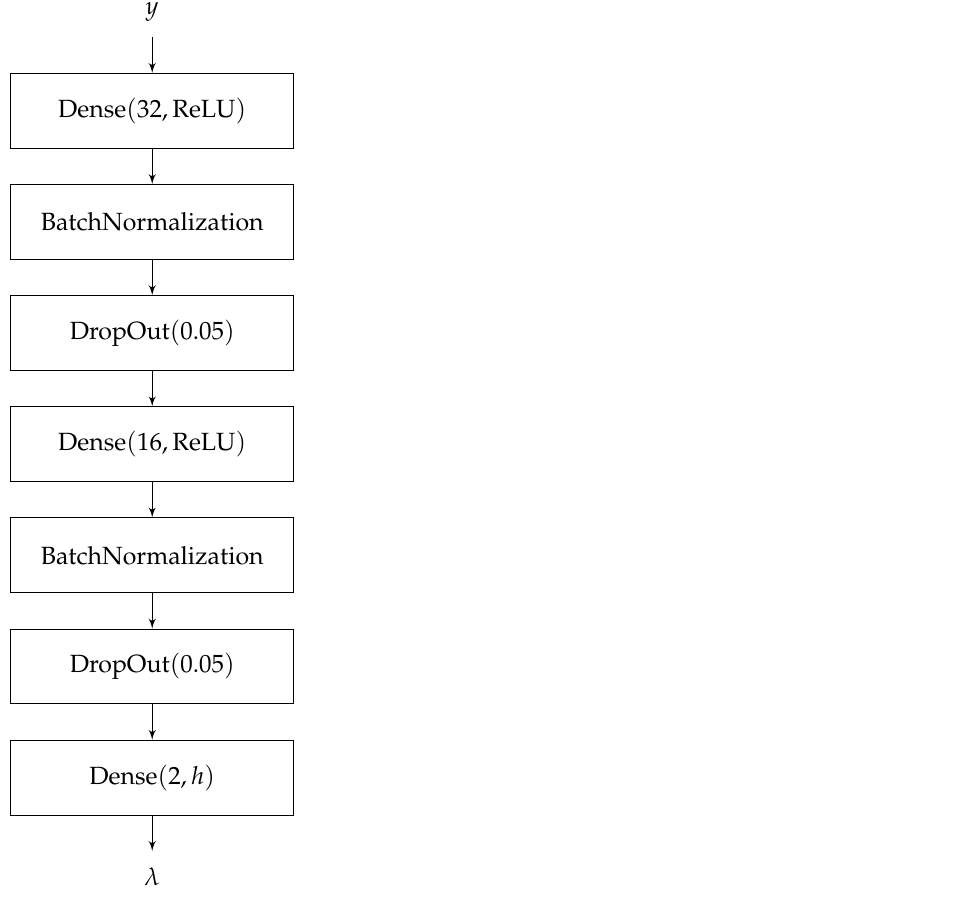
Figure 7. Structure of optimizer Λ . Dense ( n , f ) indicates a dense layer with n nodes and activation function f : R n → R n . DropOut ( r ) indicates the dropout layer with dropout rate r . ReLU is short for rectified linear unit function.